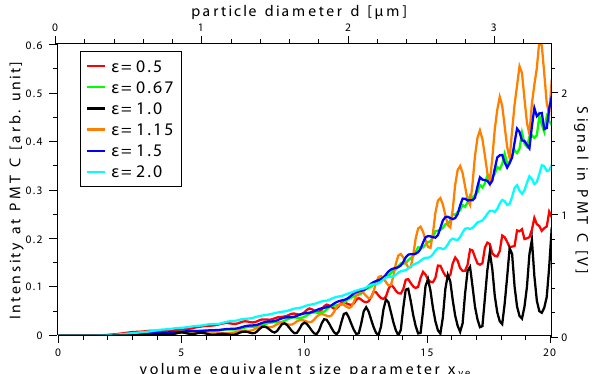
Fig. 2. Intensity integrated over the detector area (PMT C) I d sus volume-equivalent size parameter x ve for randomly oriented spheroids with different aspect ratios (cid:15) . Here and in the follow- ing figures, the axis on top shows particle diameter correspond- ing to x ve (bottom axis) and the wavelength of the TOPS-Ice laser ( λ =532nm). The axis at the right shows the measured signal voltage in PMT